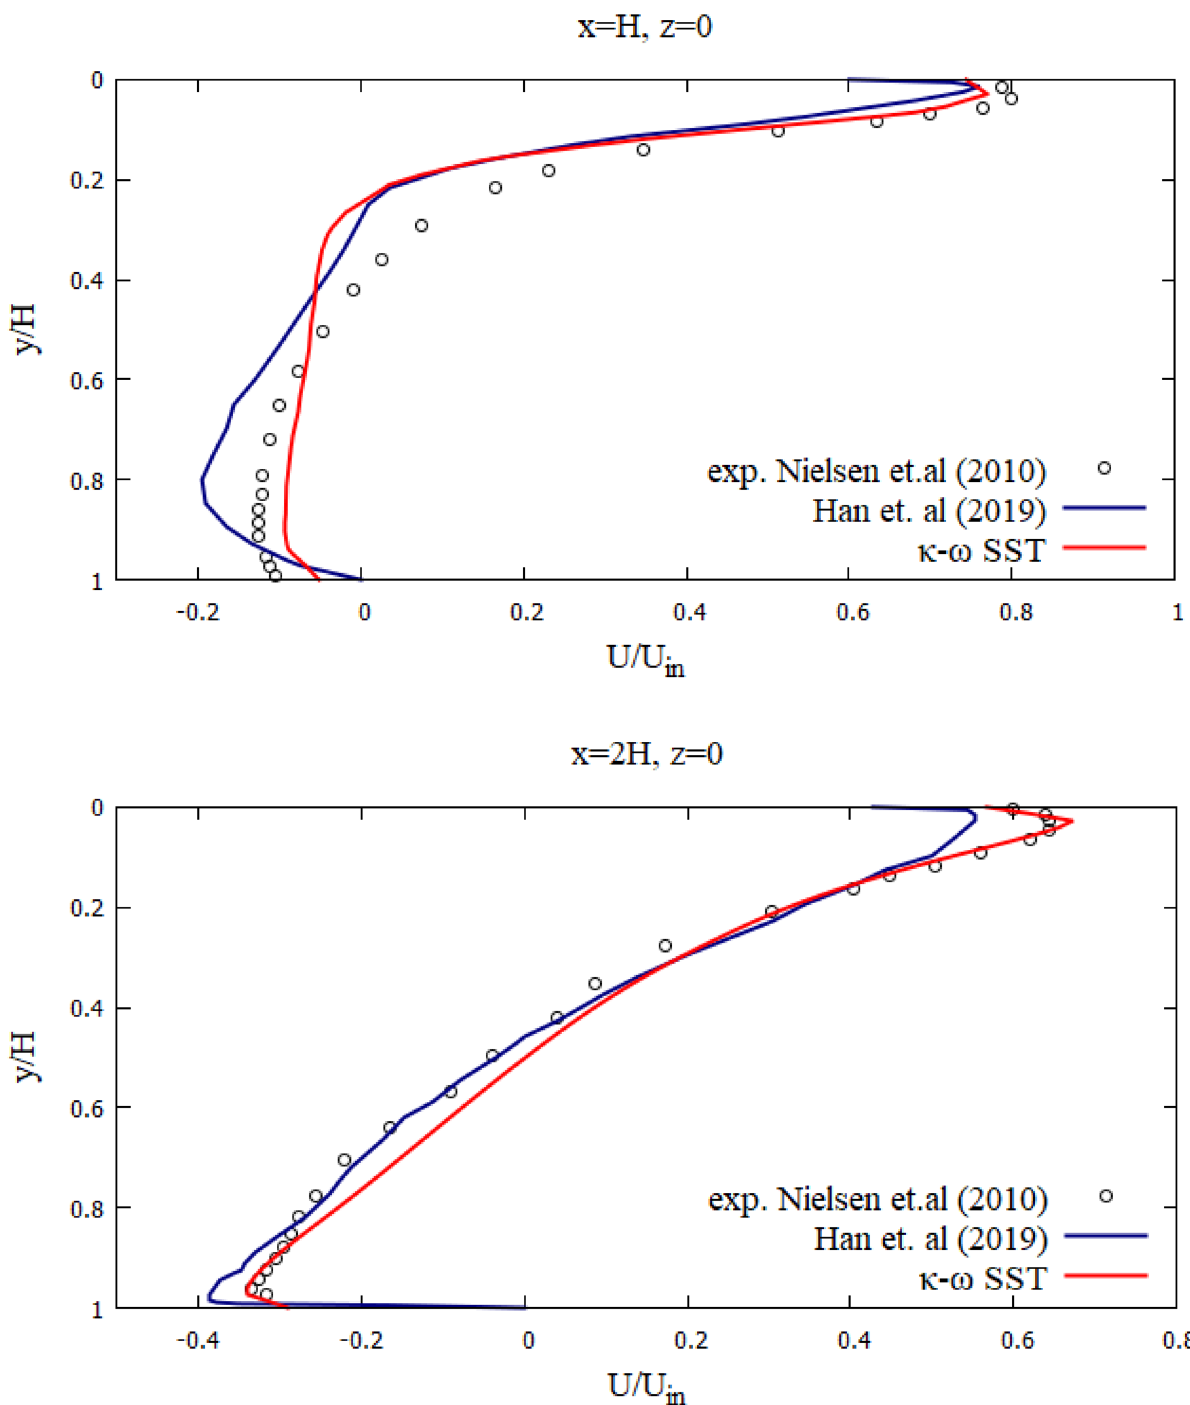
Figure 3. Comparison of the numerical results of the velocity profiles, with the values of the experiment by Nielsen et al. 84 and the results of Han et al. 85